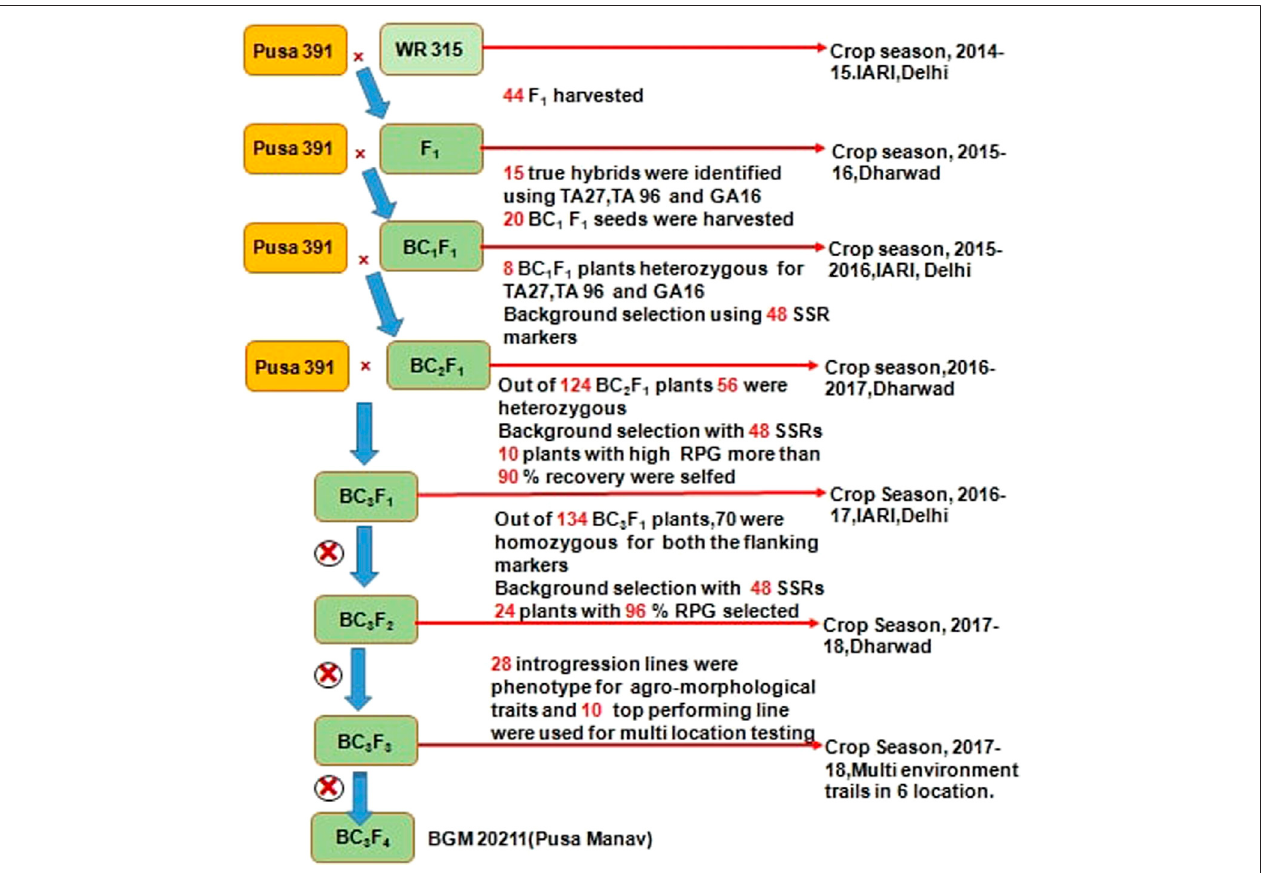
FIGURE 1 | Detailed representation of marker assisted back cross bred lines of Chickpea for Fusarium wilt at ICAR-IARI.